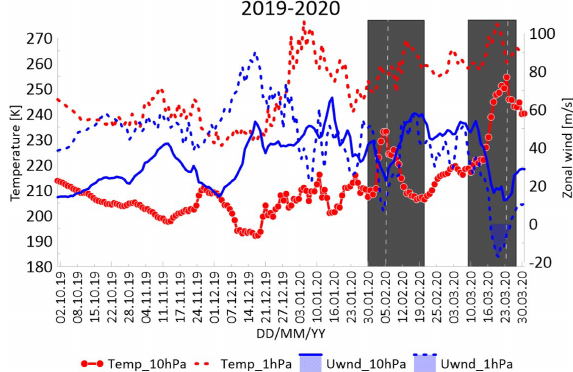
Figure 11. Same as Fig. 2 but October 2019 through March